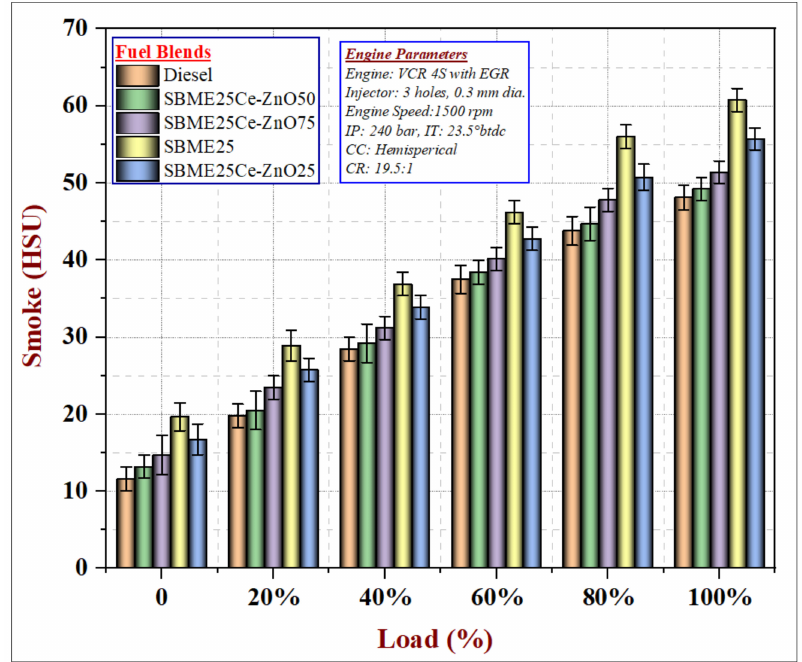
Figure 12. Variation of smoke with load for di ff erent fuel